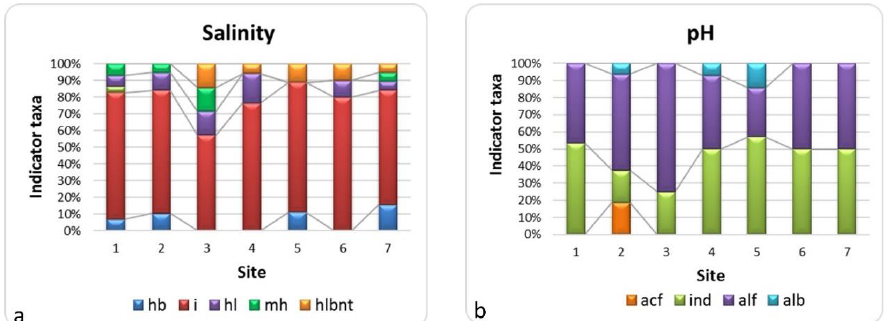
Figure 9. Ecological preferences of water salinity ( a ) and pH ( b ) indicators in the communities of studied sites in the Abraham Lincoln Birthplace National Historical Park. Abbreviations of site names follow those used in Tables 1 and 2. Abbreviation of ecological groups as in Table 3. Ecological groups of salinity indicators: hb, halophobes; i, chloride-tolerated (indi ff erent); hl, halophiles; mh, mesohalobes; hbnt, halobiontes. Water pH indicators: acf, acidophiles; ind, pH-indi ff erents including neutrophiles; alf, alkaliphiles; alb,